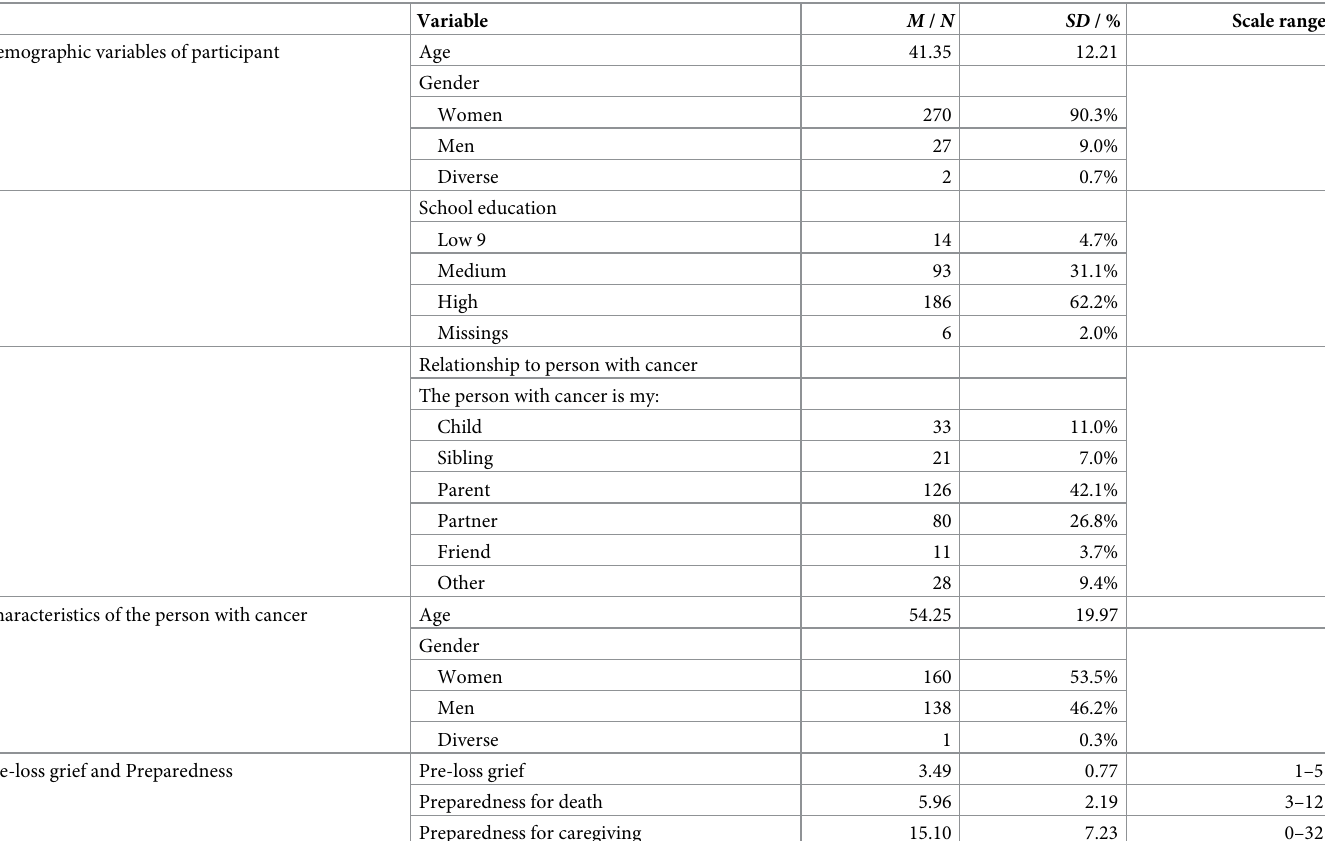
Table 2. Characteristics of the